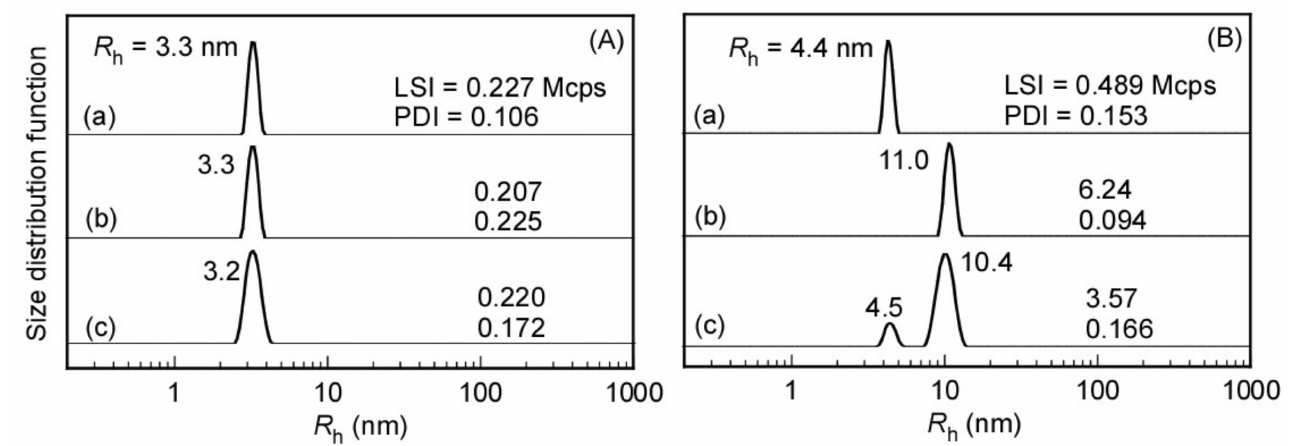
Figure 4. Hydrodynamic radius ( R h ) distributions of ( a ) P(MPC/DPAEMA50) 107 , ( b ) PMPC 52 - b - PDPAEMA 56 , and ( c ) an equimolar mixture of the random and block copolymers at a total polymer concentration of 10 g/L in 0.1 M NaCl at pH 3 ( A ) and 10 ( B ) at 25 ◦